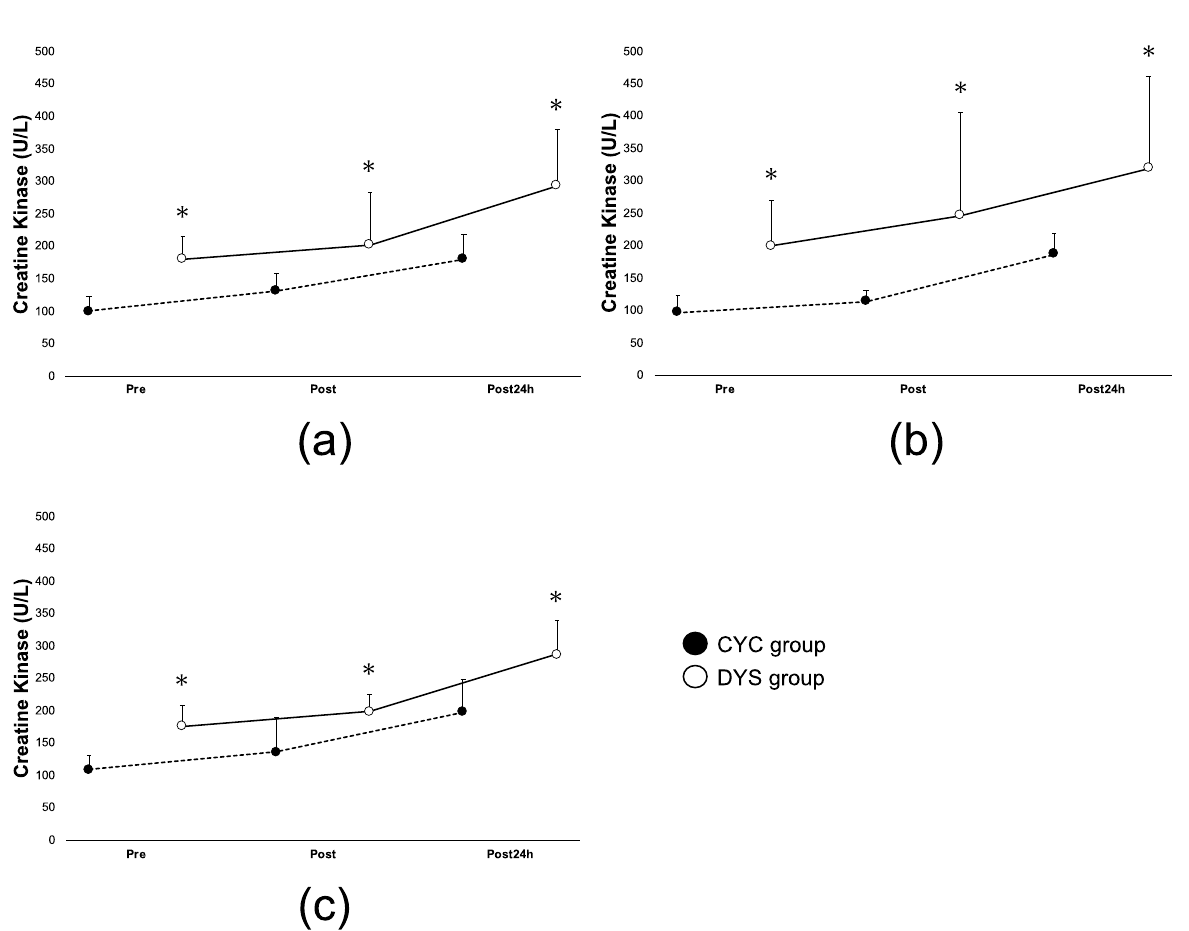
Figure 2. Variance of creatine kinase (CK) levels in exercise (EX) condition. ( a ) CK level from pre-exercise to Post 24 h in Week 1, ( b ) CK level from pre-exercise to Post 24 h in Week 2, ( c ) CK level from pre-exercise to Post 24 h in Week 3. The CYC group is represented by black circle markers and the DYS group by white circle markers. Error bars represent SD. * indicates p < 0.05 between CYC and DYS group in time point.